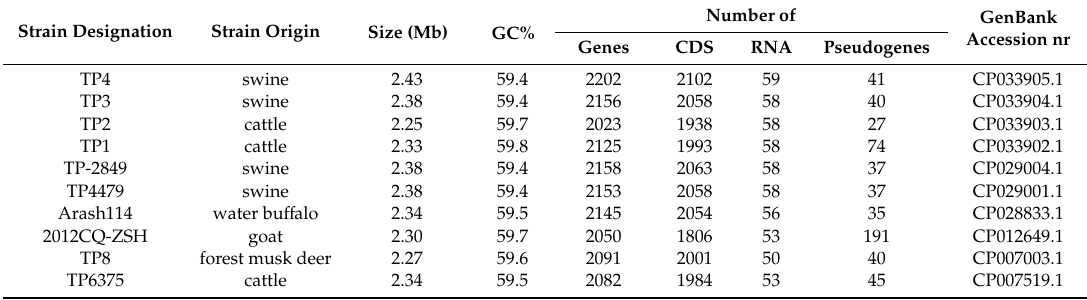
Table 1. General features of the complete T. pyogenes genomes available in the GenBank nucleotide database